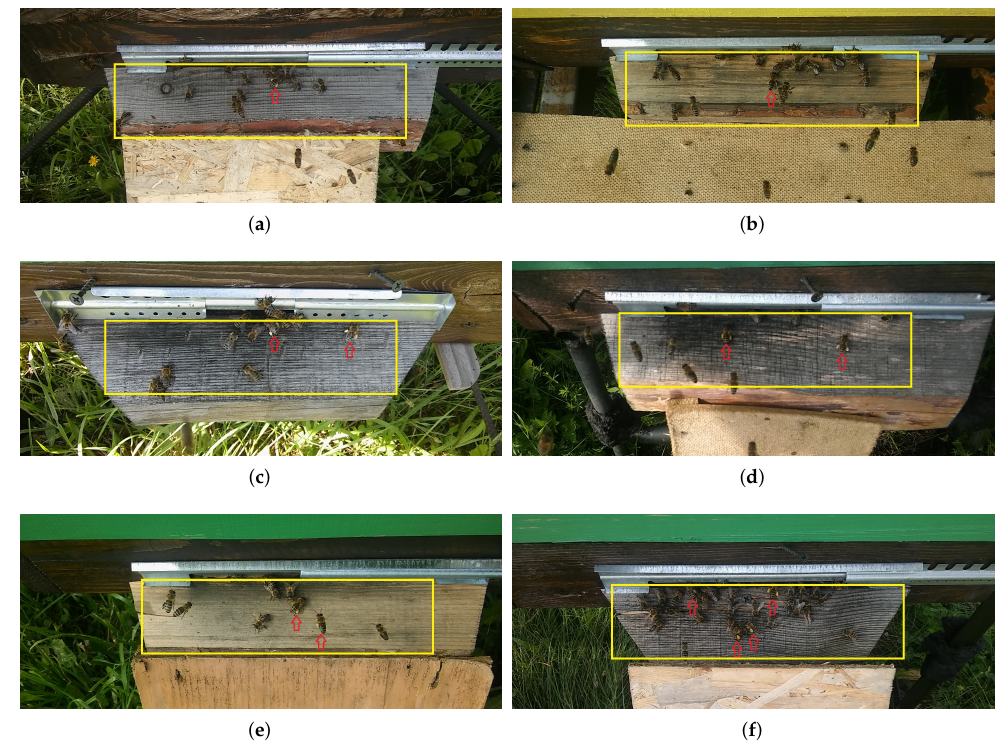
Figure 2. Bees with pollen grains (one in ( a , b ); two in ( c – e ); four in ( f )) in the region of interest (yellow rectangles 1024 × 256 px in raw images) upon entrance to six different